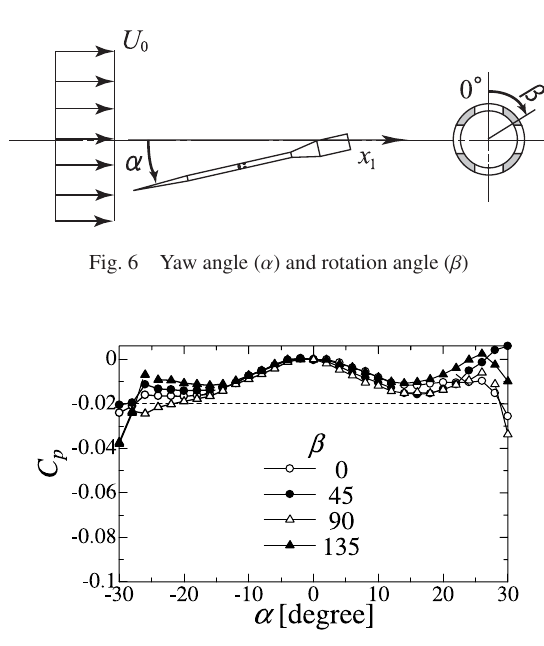
Fig. 7 Yaw angle ( α ) characteristics of